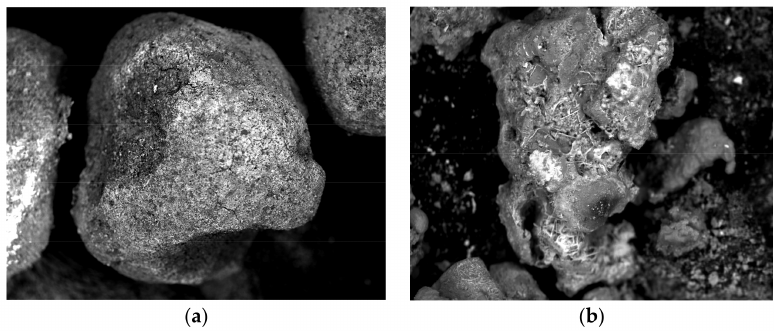
Figure 17. SEM images of MgO_nZVI ( a ) and of commercial mZVI particles ( b ) after the lead removal